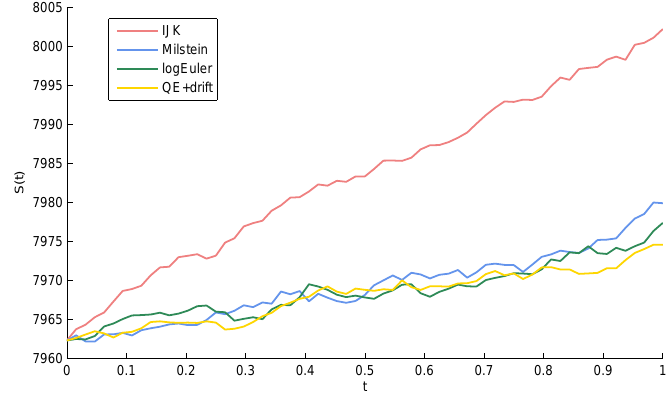
Fig. 9. Mean of 100000 paths using parameters from Table 4, (cid:129) D 2 (cid:0) 6 and T D 1